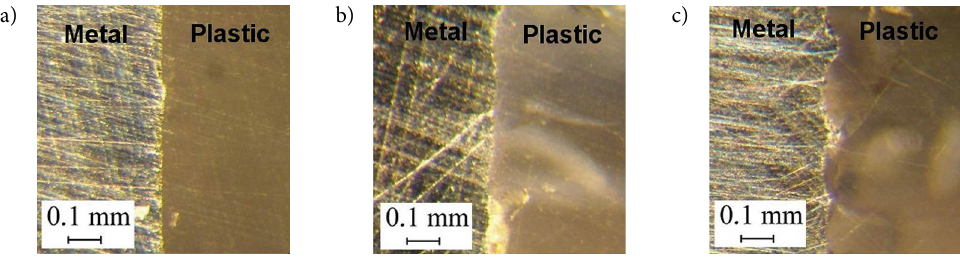
Fig. 11. Metal-plastic interfaces in case of different average surface roughness at lateral surface (source: own photos): a – Ra = 0.7 m m; b – Ra = 6.4 m m; c – Ra = 9.1 m